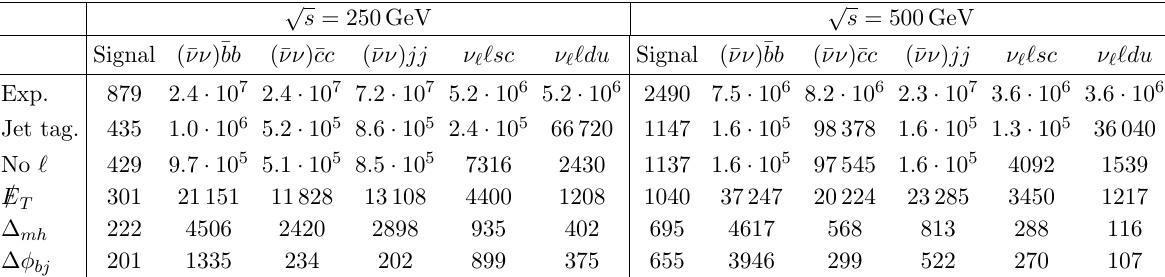
Table 5. Cut(cid:13)ow table for the signal and backgrounds in the neutrino channel at 250 GeV with 2 ab (cid:0) 1 and polarisation sharing of scenario 1 and 500 GeV with 4 ab (cid:0) 1 and polarisation sharing of scenario 2. For the signal we have assumed